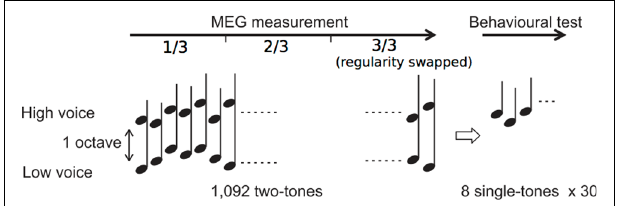
FIGURE 1 | Experimental procedure. Two simultaneous sequences consisting of high- and low-voice sequences were presented during magnetoencephalography (MEG) measurement. After the measurement, behavioral tests were